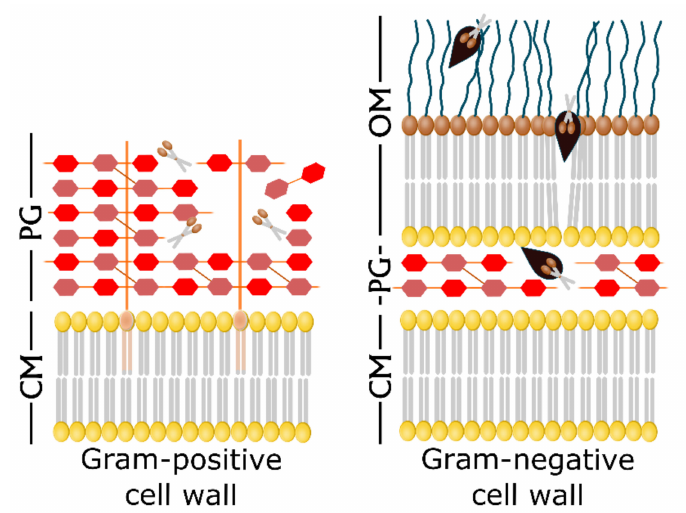
Figure 2. Exogenous addition of endolysins and Artilysin ® s against the bacterial cell wall. The Gram-positive cell wall is directly accessible to exogenous endolysins (scissors) that cleave the peptidoglycan (PG) bonds, leading to the cell lysis (left panel). On the contrary, natural endolysins are not able to pass through the outer membrane (OM) of Gram-negative cells to attack the PG layers. Artilysin ® s are engineered enzymes with an additional LPS-destabilizing peptide (black) that enables the endolysin to reach the PG and cleave it (right panel). Adapted from